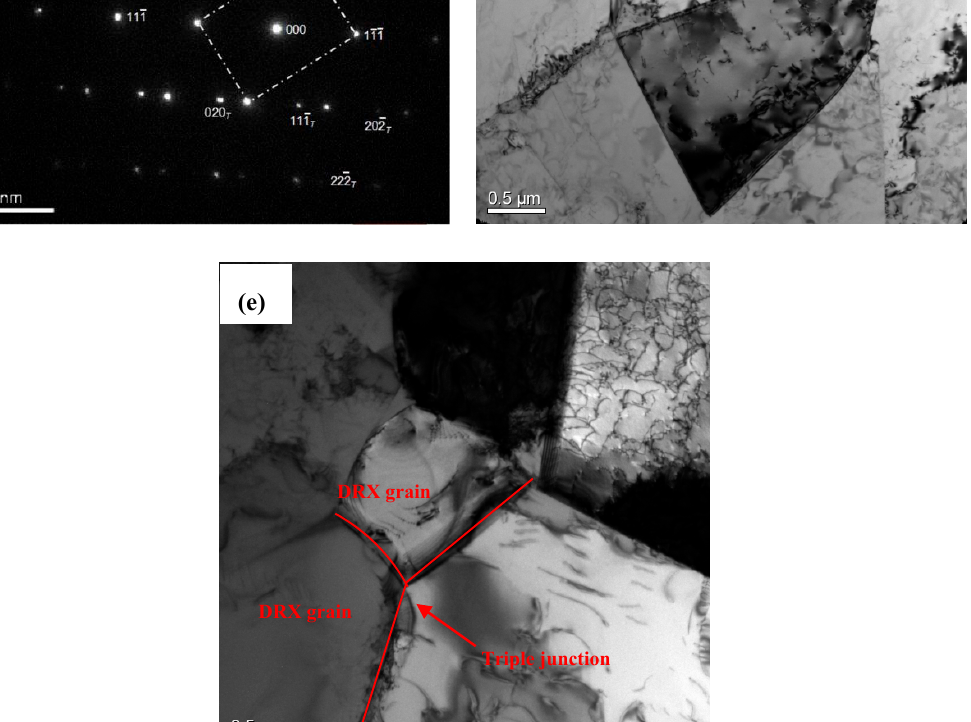
[ ] (cid:104) (cid:105) 101 axis zone of twin (marked by arrows) T 101 axis zone of twin (marked by arrows) T